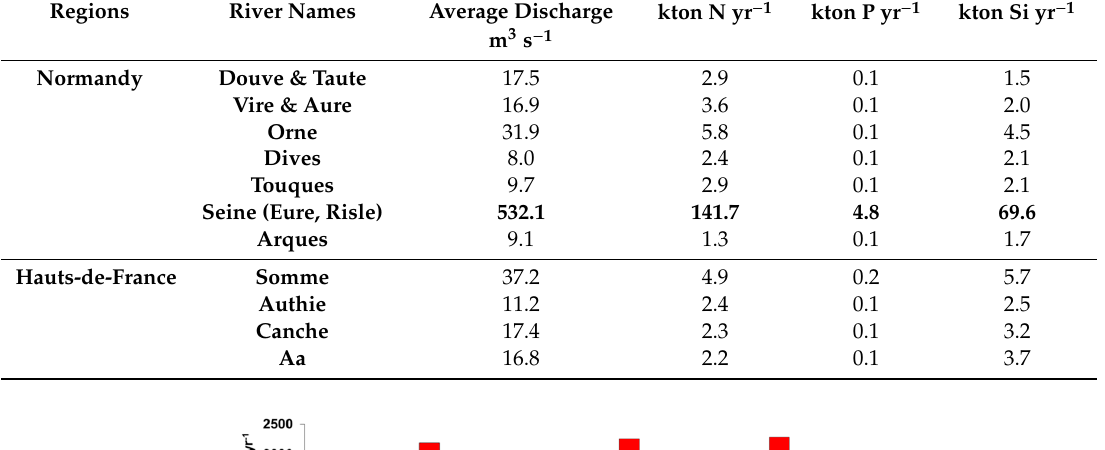
Table 5. Average discharge and nutrient fluxes at the outlet of the rivers averaged for 2002–2014 (total N, P, and Si in kton y − 1 ). The Douves and Taute on the one hand and Vire and Aure on the other hand are considered together as they meet before flowing to the coastal zone.